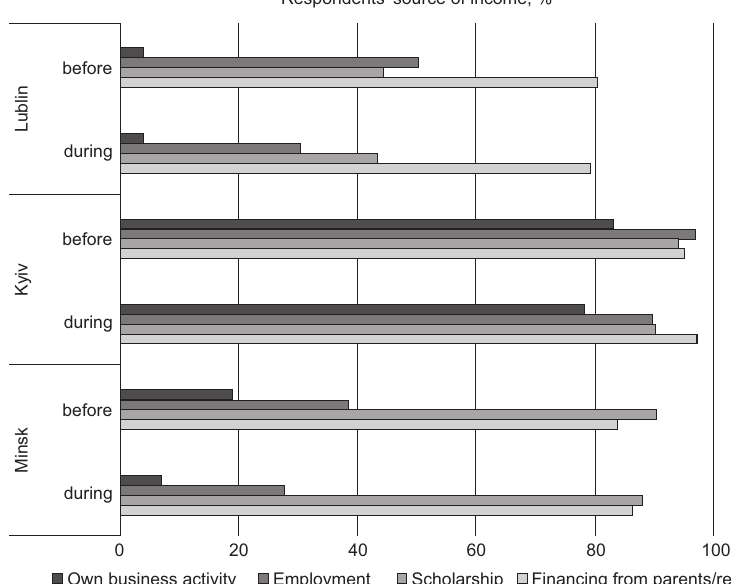
Fig. 1. Students’ source of income and employment in Lublin, Kyiv and Minsk before and during the pandemic, % (n = 380). Source: results of own survey